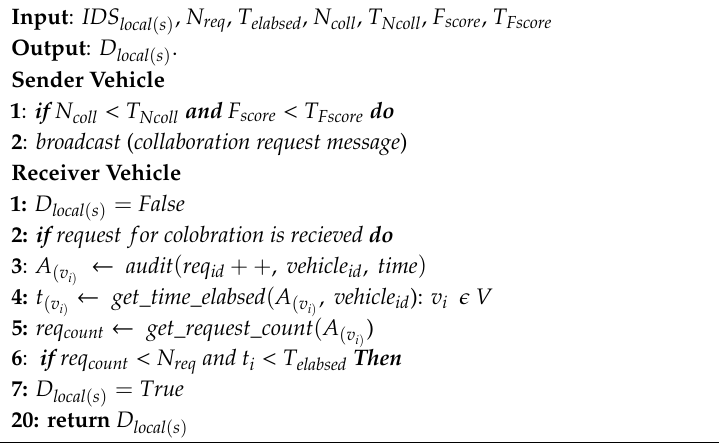
Algorithm 1: On-Demand IDS Classifier Sharing Algorithm